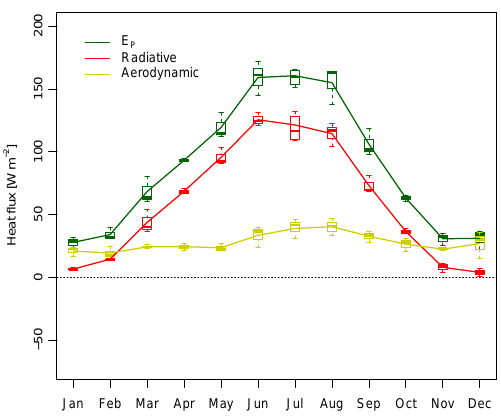
Figure 7. Monthly mean evaporation, E P , with radiative and aero- dynamic terms for the Penman equation. Meaning of boxes, line segments, and notches are defined in the caption of Fig. 4.